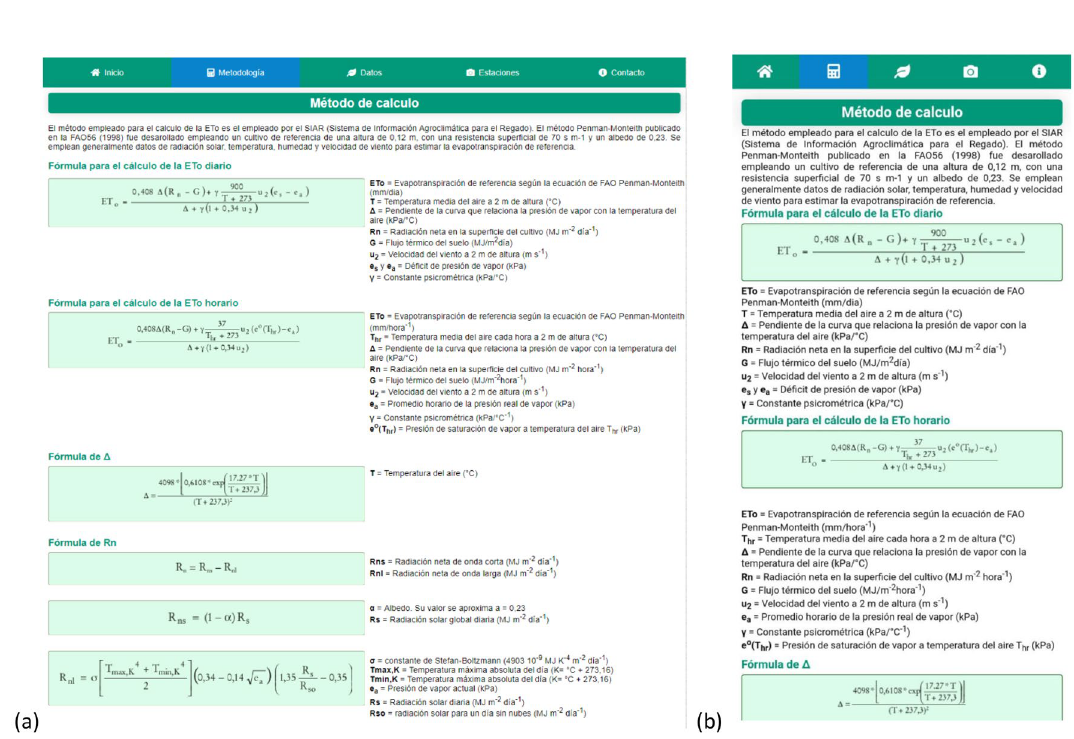
Figure 3. View of the tab with information about the methodology followed in ( a ) the web application and ( b ) the mobile